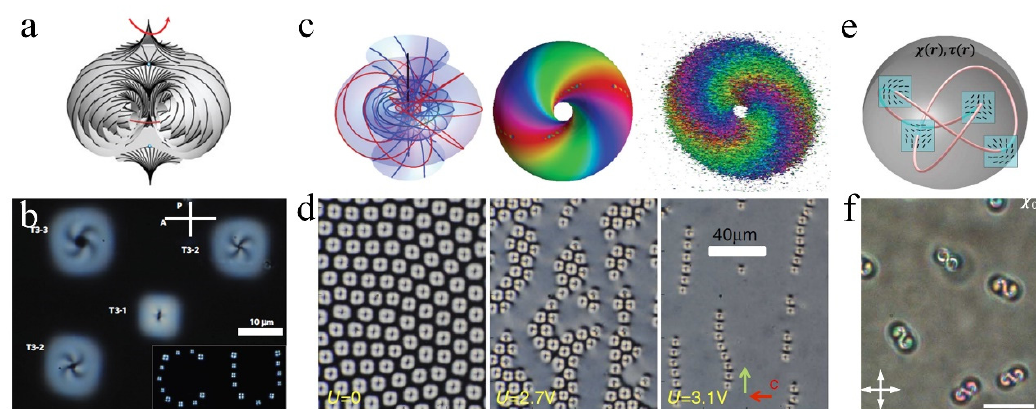
Figure 6. ( a ) Configuration of a toron. ( b ) Polarizing microscopy texture of different defect-prolifer- ated torons. Reprinted with permission from Ref. [63]. Copyright 2010 Nature. ( c ) Flow lines and